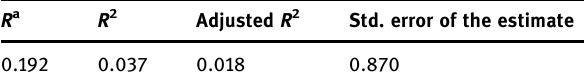
Table 14: Summary for model two